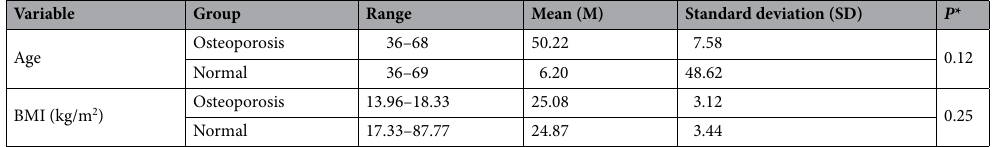
Table 2. Frequency distribution of participants in two groups of osteoporosis and normal in terms of age and body mass index (BMI). BMI body mass index. *Independent